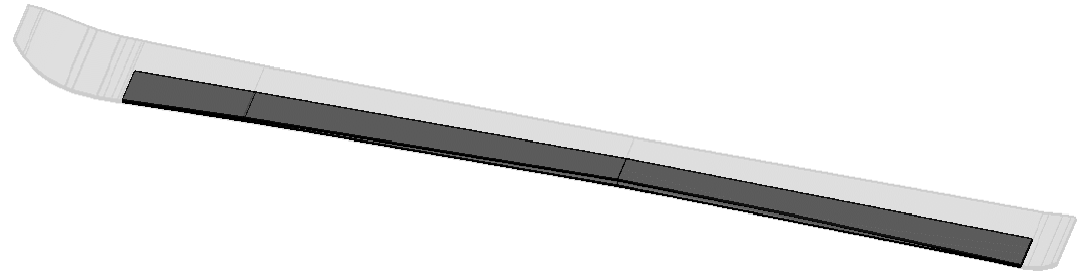
Figure 5. Isometric view of the solid model used for the three-point-bending test.